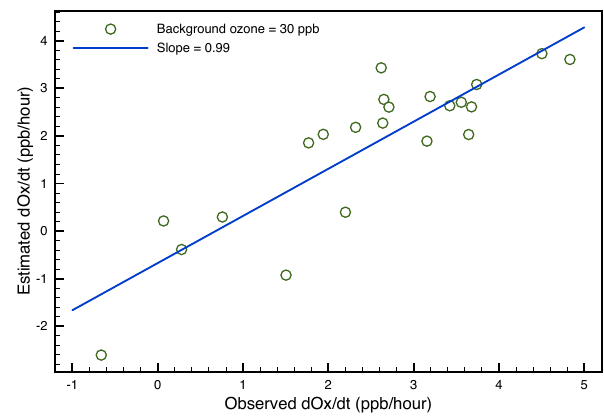
Figure 8. Correlation of the estimated daytime hourly O 3 produc- tion rate corrected for dilution loss to what was observed from O 3 and NO 2 data. A background O 3 concentration of 30ppb was as-